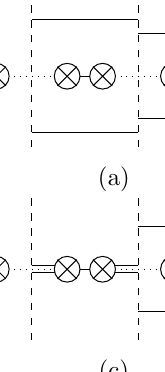
Figure 24. A 1 Kraft-Procesi transition starting from the model with and rightmost orientifold plane O 3 (cid:0) . (a) Higgs branch brane con(cid:12)guration of the starting model. Its Higgs branch is M H = (cid:22) O . (b) The physical D3-brane is aligned with the half (3 ; 1)